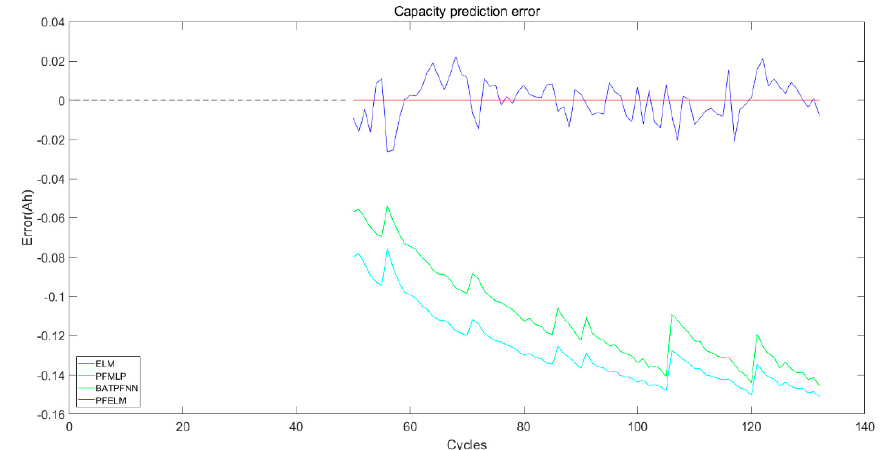
Figure 25. Capacity prediction error from the 50th cycle.